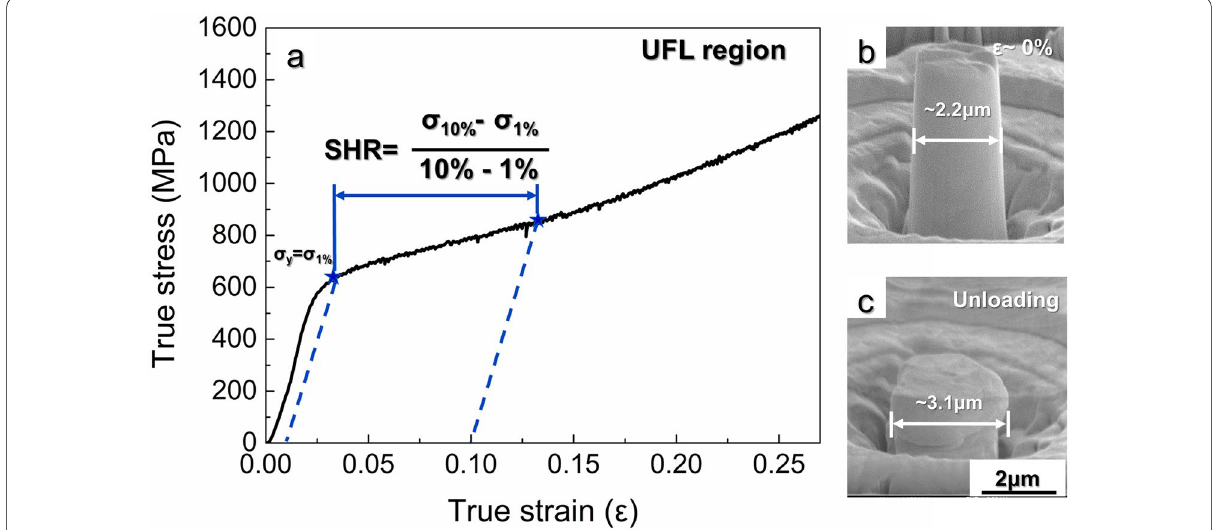
Figure 5 ( a ) True stress-strain curve of the UFL micropillar. SEM snapshots at ( b ) ε~ 0% and ( c ) unloading during